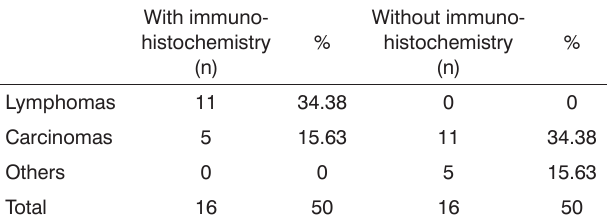
Table 2. Immunohistochemistry use according to histogenic cell lines.